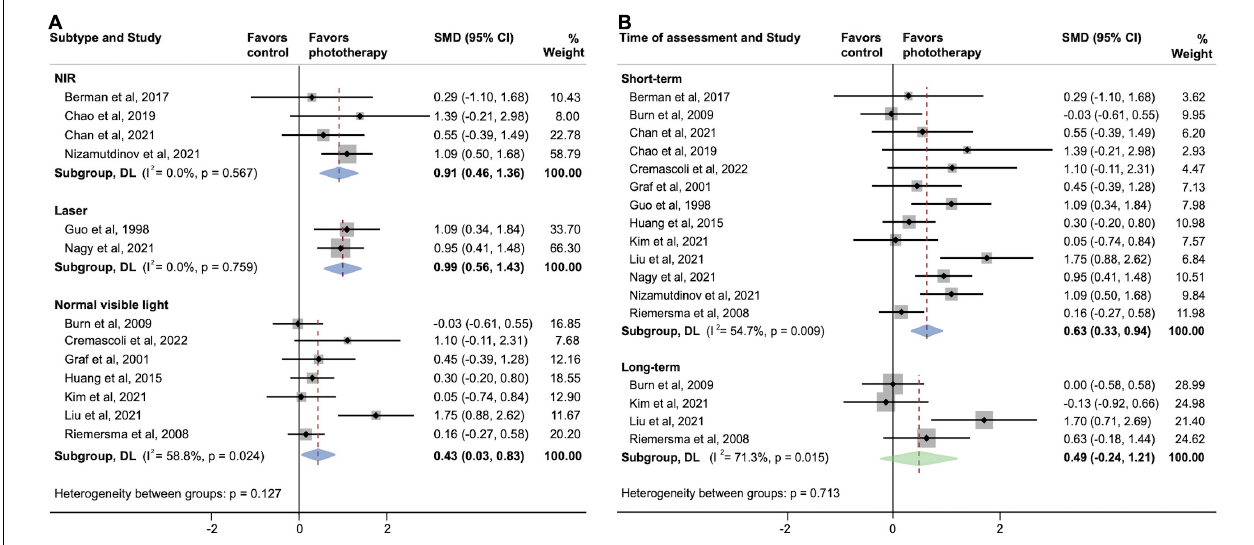
FIGURE 4 | Subgroup analyses evaluating cognitive improvement, stratified by (A) phototherapy subtypes and (B) time of assessment. NIR, near-infrared; SMD, standardized mean difference. Weights and between-subgroup heterogeneity test are from random-effects model.